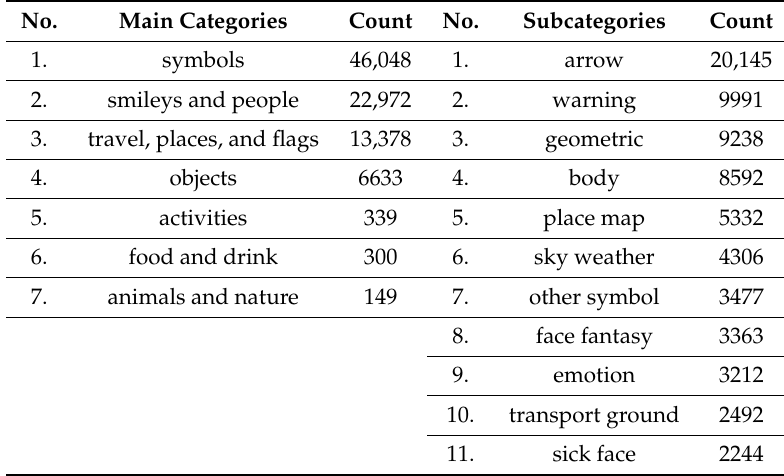
Figure 2. Social network analysis of Twitter users and mentions (for a more detailed graph, please see the following link: http: // gorilladragon.org / COVID_bots / ). Table 3. The main categories and subcategories of bots’